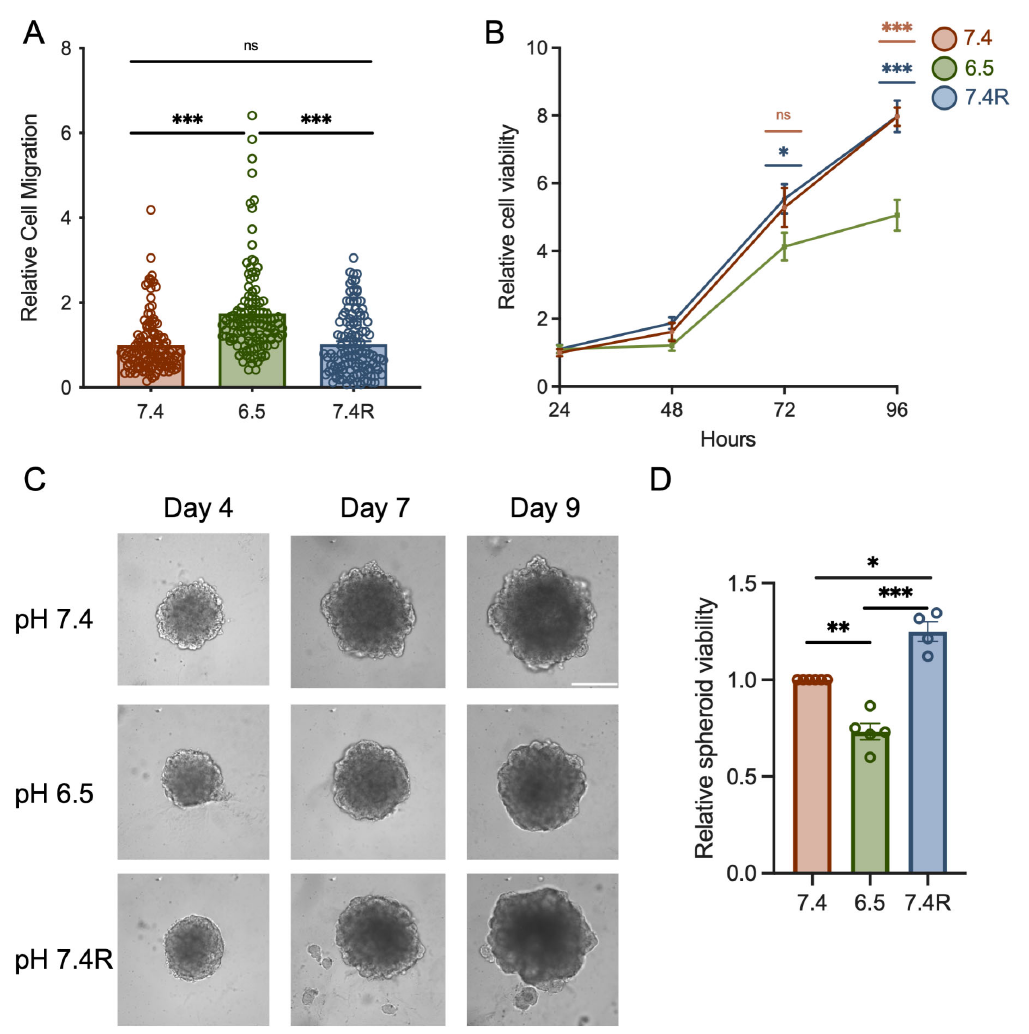
Figure 2. Acid adaptation promotes PANC-1 cell migration but attenuates proliferation, which is restored upon acid recovery. ( A ) Cell migration of PANC-1 cells grown under normal pH (7.4), acid-adapted (6.5), or acid recovery conditions (7.4R) analyzed by Boyden chamber assay ( n = 3). ( B ) Trypan blue analysis of PANC-1 cells grown under normal pH (7.4), acid-adapted (6.5), or acid recovery conditions (7.4R) shows the relative number of viable cells after 24, 48, 72, and 96 h after seeding ( n = 3). ( C ) Representative images of PANC-1 spheroids grown for 9 days and ( D ) viability quantification performed with CellTiter-Glo ® assay ( n = 4–5), scale bar = 400 µ m. Welch’s correction t -test was used to determine the significant difference between different conditions. ns indicates non ‐ significance. *, **, and *** indicate p < 0.05, 0.01, and 0.001, respectively.